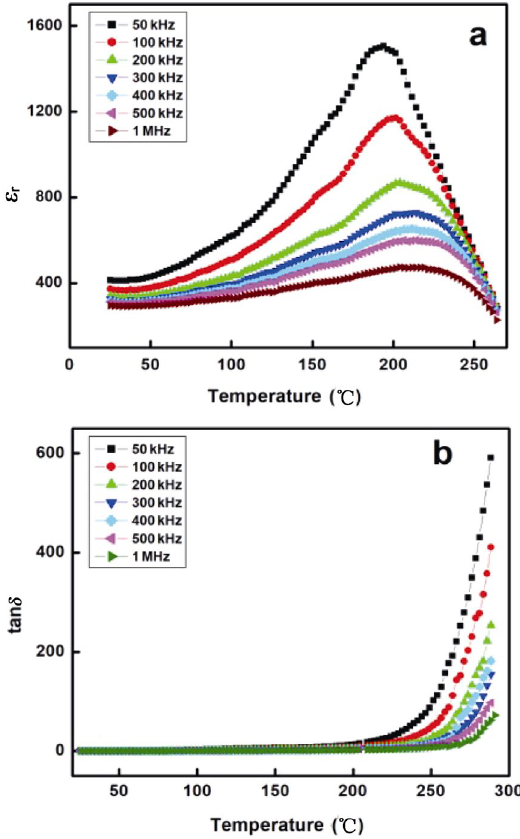
Fig. 2 (a) Variation of relative dielectric constant and (b) tan δ with temperature at some selected